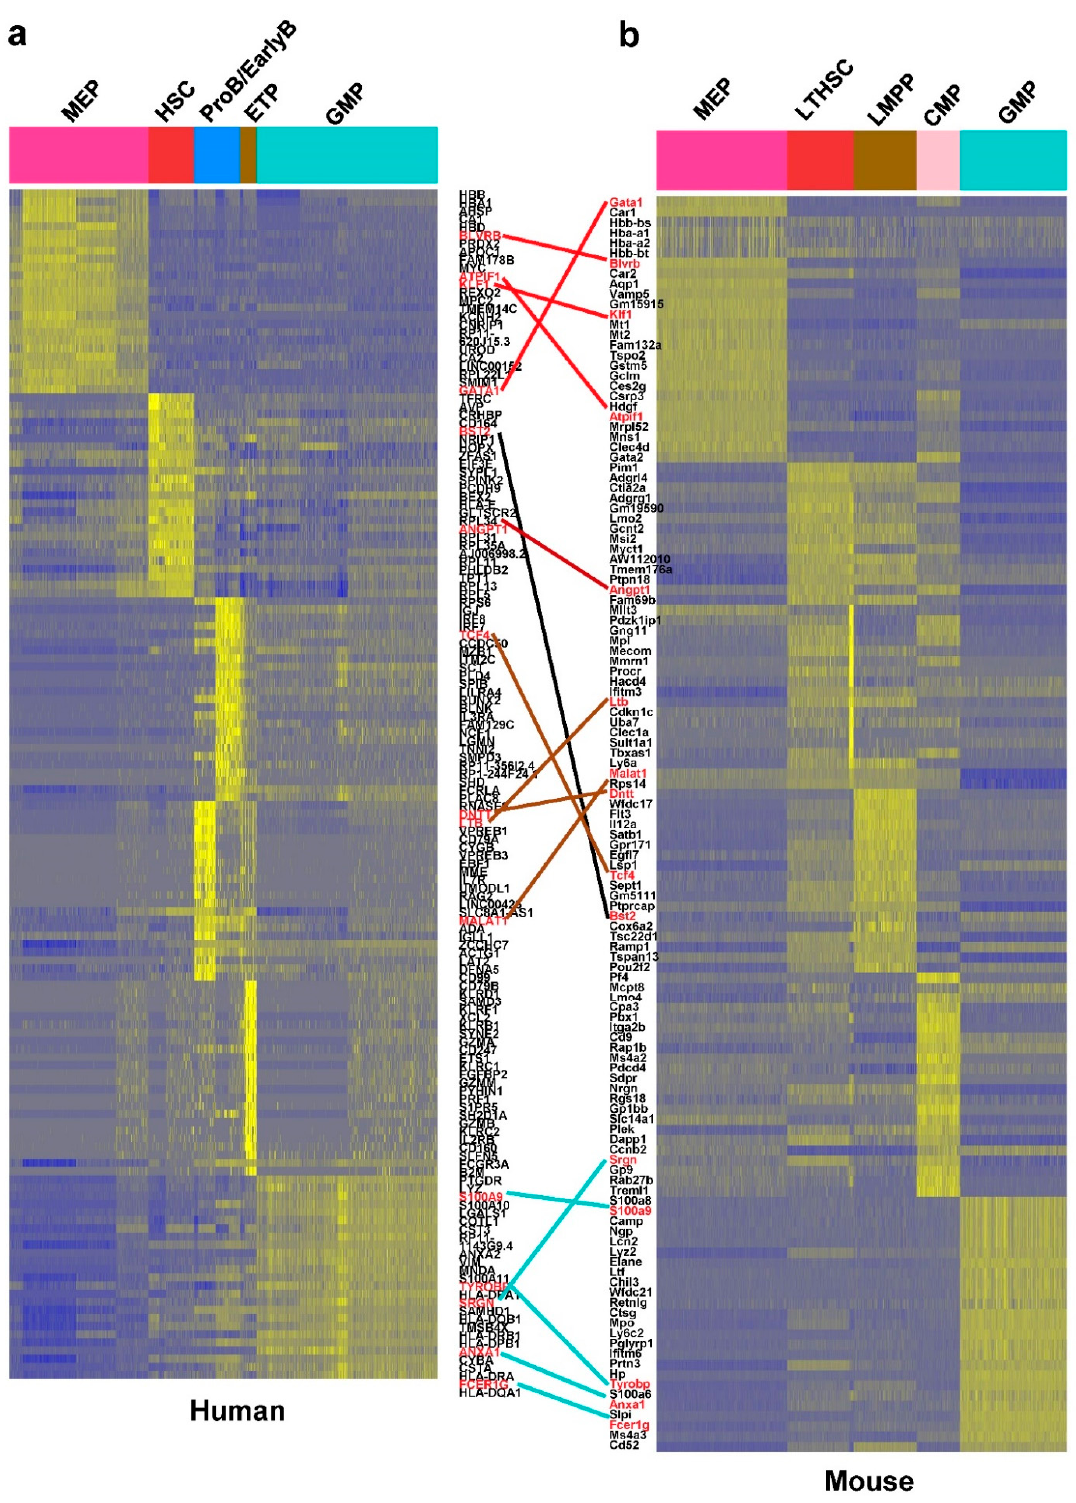
Figure 2. Heatmaps of differentially expressed genes in ( a ) human and ( b ) mouse cell populations. Heatmaps showed a scaled gene expression of the top 25 genes representing each of the identified cell populations found in human and mouse. Each row represents one gene and each column displays gene expression of 5 pooled cells. Genes are listed in the middle and homologous genes were linked together (colored by the cell type specificity). The marker gene lists of concordant cell populations in human and mouse tend to be homologous. Note that MEP and GMP were well characterized, but others were not well characterized in human and mouse due to the characteristic of cell